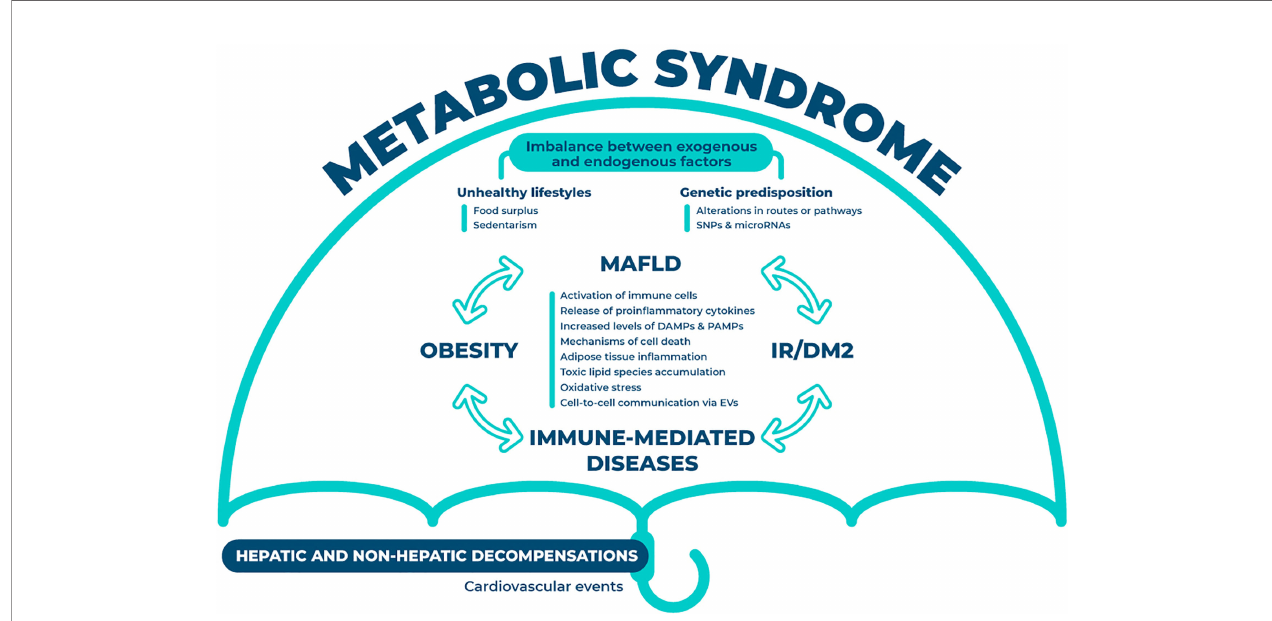
FIGURE 1 | Interorgan crosstalk in MAFLD. The crosstalk between different organs and systems is summarized in this fi gure. Under the umbrella of metabolic syndrome, this disease is partially dictated through the imbalance between endogenous (i.e. genetic predisposition) and exogenous factors (i.e. unhealthy lifestyles). The interplay between MAFLD, insulin resistance or diabetes mellitus type 2, obesity and immune-mediated diseases is constant and occurs in all directions. This plethora of interactions will result in the aberrant activation of various mechanisms (i.e. immune cells, oxidative stress and cell death) that will eventually foster the hepatic and non-hepatic decompensations. MAFLD, metabolic associated fatty liver disease; SNPs, single nucleotide polymorphism; IR, insulin resistance; DM2, diabetes mellitus type 2; DAMPs, damage-associated molecular patterns; PAMPs, pathogen-associated molecular patterns; EVs, extracellular